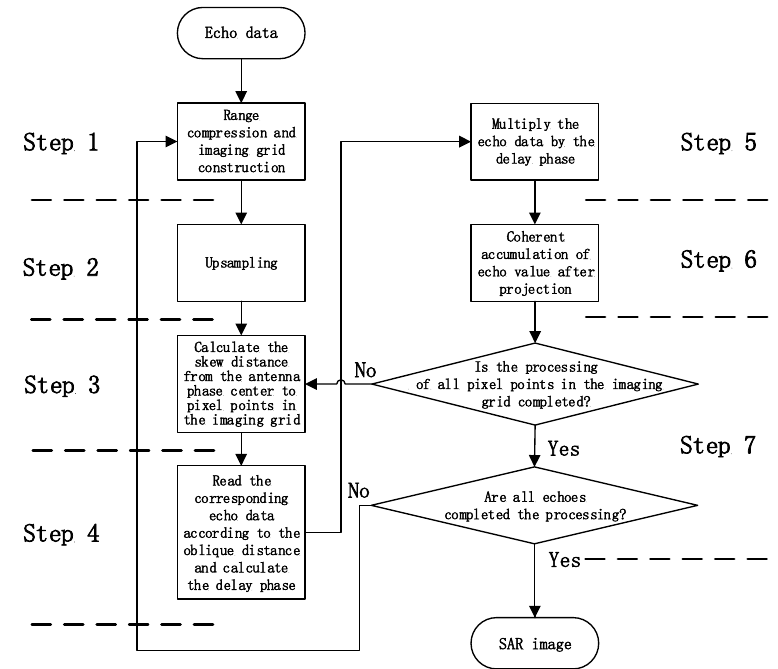
Figure 4. BP flow chart of the imaging algorithm.